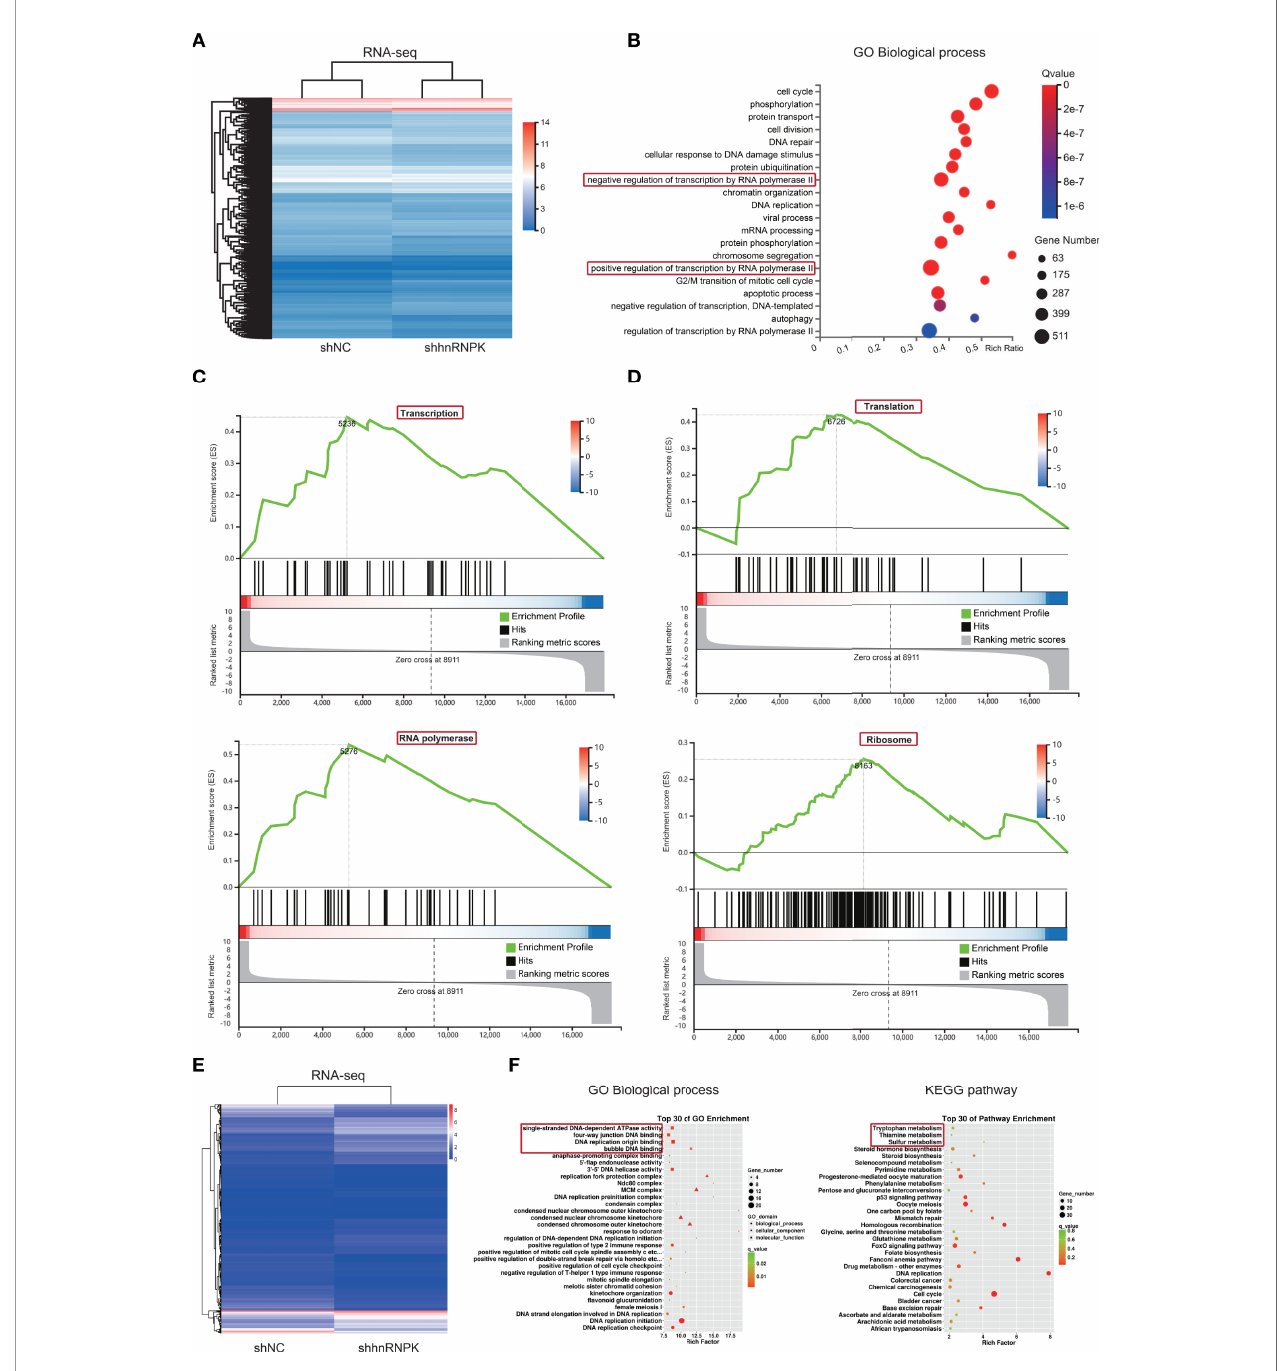
FIGURE 7 | RNA-seq in HCT116 cell lines revealed that hnRNPK from hnRNPK/A1/R/U complex mainly regulated cellular transcription and translation. (A) To identify the biological functions of hnRNPK in colorectal adenocarcinoma cells, the primary biological processes that hnRNPK is involved in were analyzed by RNA- seq in HCT116 cells. The heatmap was constructed after hnRNPK knockdown. (B) By GO analysis of the differential genes, regulation of transcription by RNA polymerase II was identi fi ed as the primary biological function of hnRNPK. (C, D) Regulation of transcription by RNA polymerase II and translation by ribosome were identi fi ed as the primary biological processes according to the GSEA. (E, F) In FHC cells, the primary biological functions of hnRNPK were further analyzed by RNA- seq. By GO analysis of the differential genes, regulation of DNA binding was identi fi ed as the primary biological function of hnRNPK. KEGG pathway analysis con fi rmed that the differential genes were mainly enriched in metabolism signaling